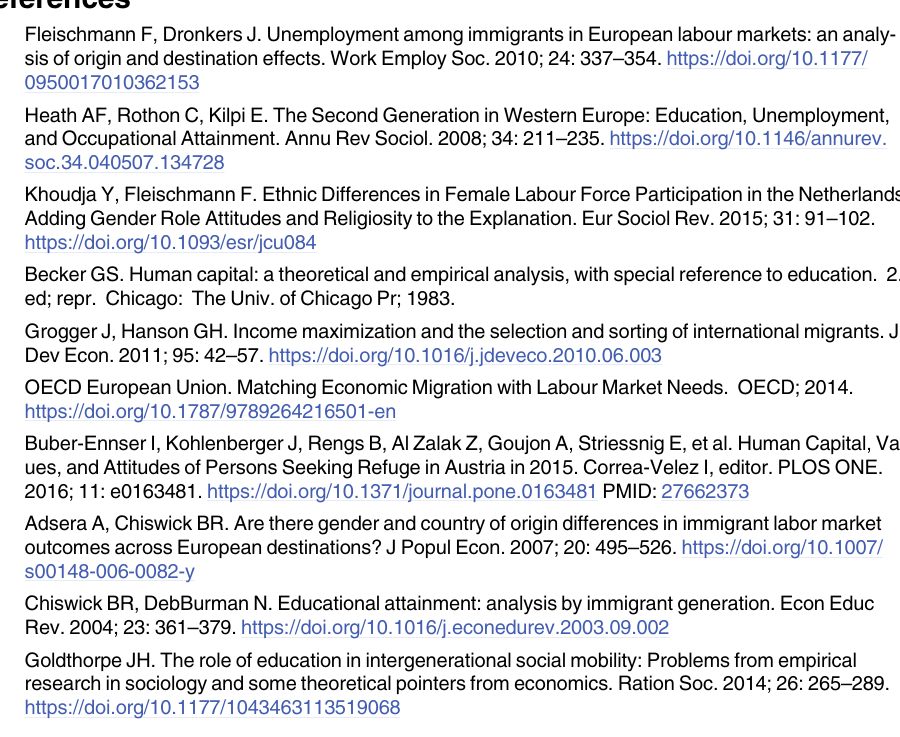
S5 Table. Sensitivity analysis: Stratified cox proportional hazards, time to recurrent employment